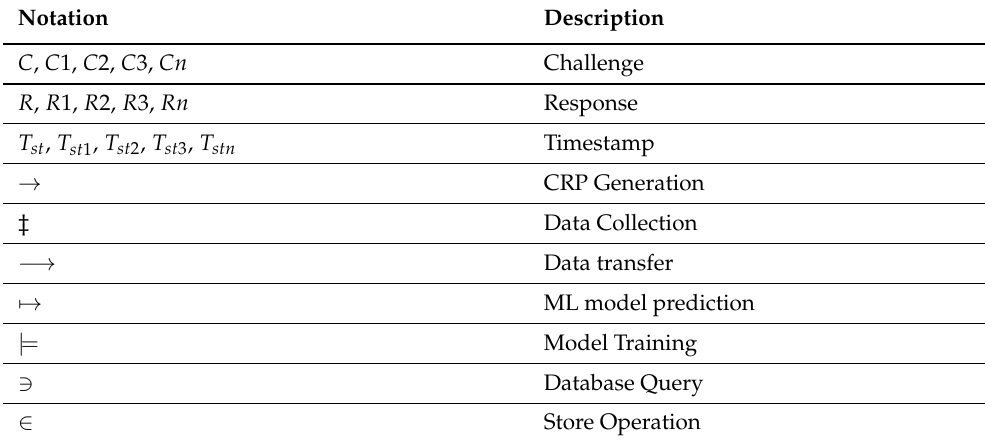
Table 1. Acronyms and symbols used in this